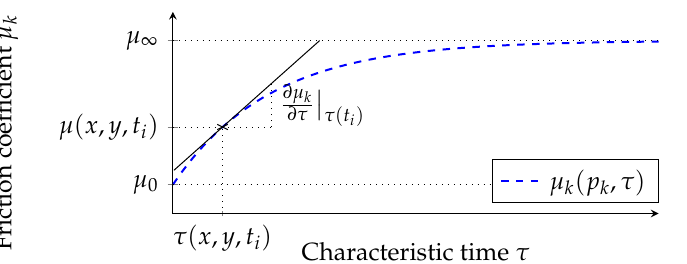
Figure 5. Extract from the friction coefficient map µ k ( p k , τ ) for the local contact pressure ¯ p ( x , y , t i ) = p k currently applied to a fixed point x , y . With the currently applied real coefficient of friction µ ( x , y , t i ) = µ k the characteristic time τ ( x , y , t i ) can be determined and thus again the gradient ∂µ k · ∂τ − 1 | τ ( x , y , t . i )